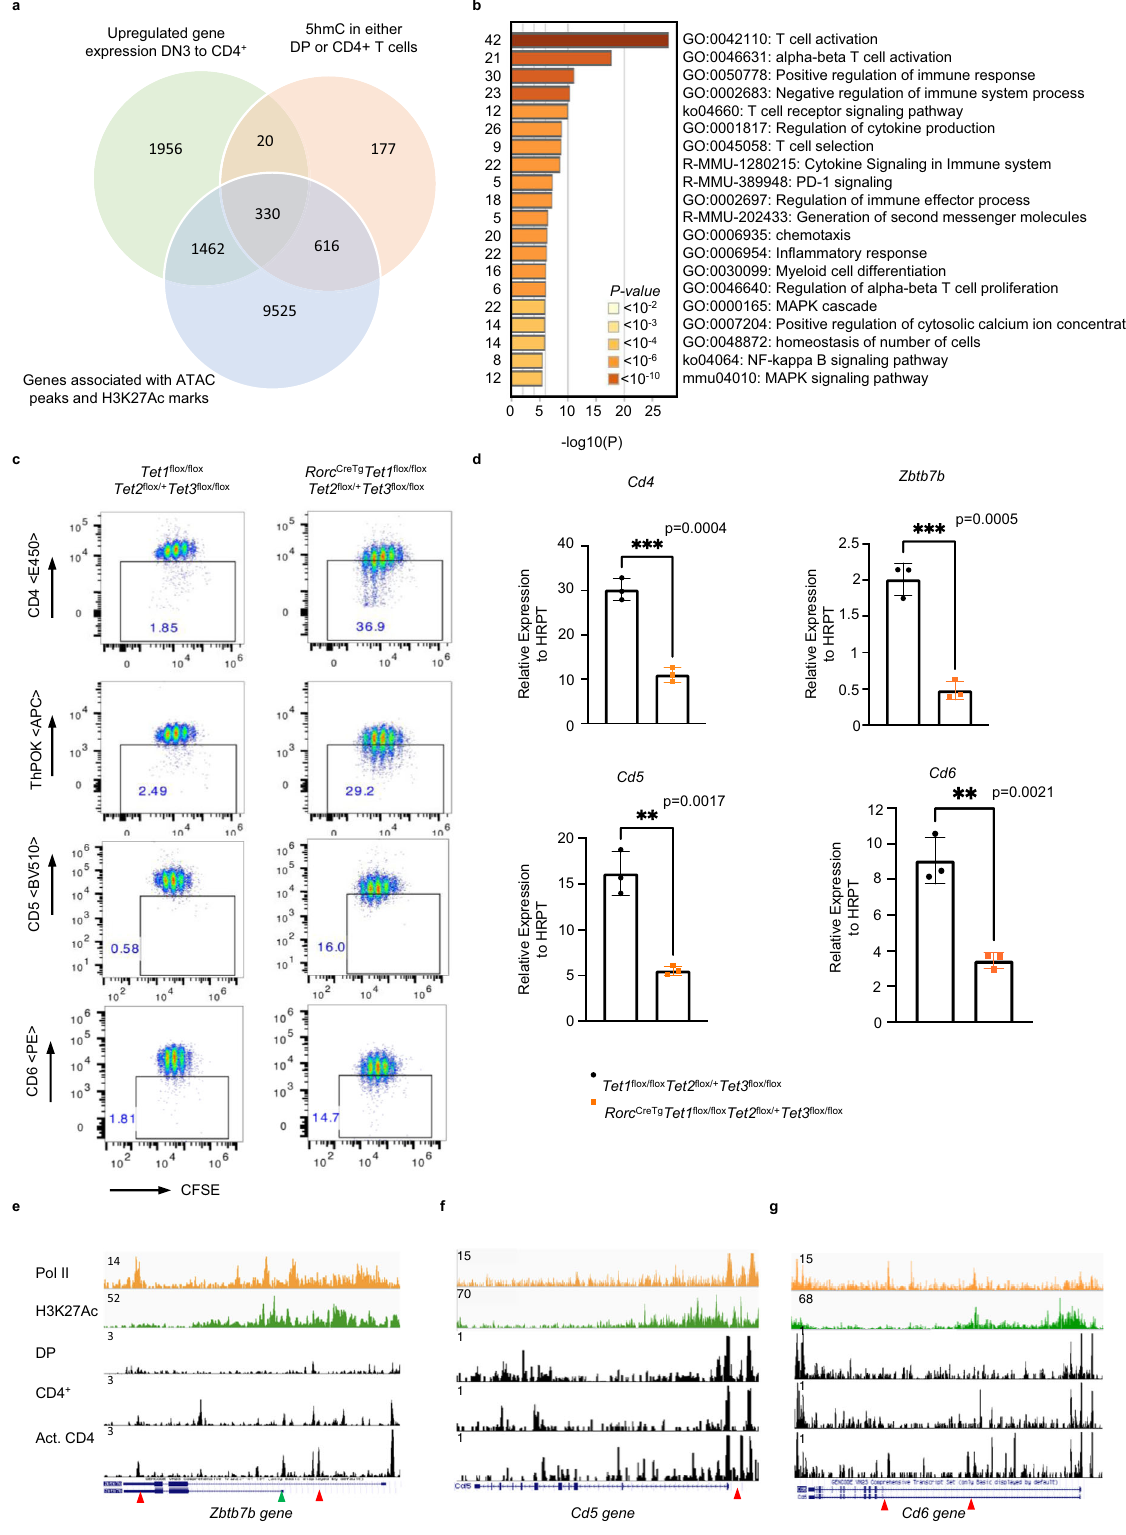
samples were removed from further analysis. The results of the differential- expression analysis were visualized in R with customized volcano plots generated using the ggplot2 graphic package. Processed data from CMS-IP experiments performed in thymocytes were downloaded from Tsagaratou et al. 2 . To identify genomic locations with acetylated histone marks (H3K27), we analyzed publicly available ChIP-Seq data from the NCBI SRA archive. The datasets (SRR5385354, SRR5385355, SRR5385352, and SRR5385353) were downloaded using the SRA toolkit and the SRA fi les were converted to fastq fi les for processing. The